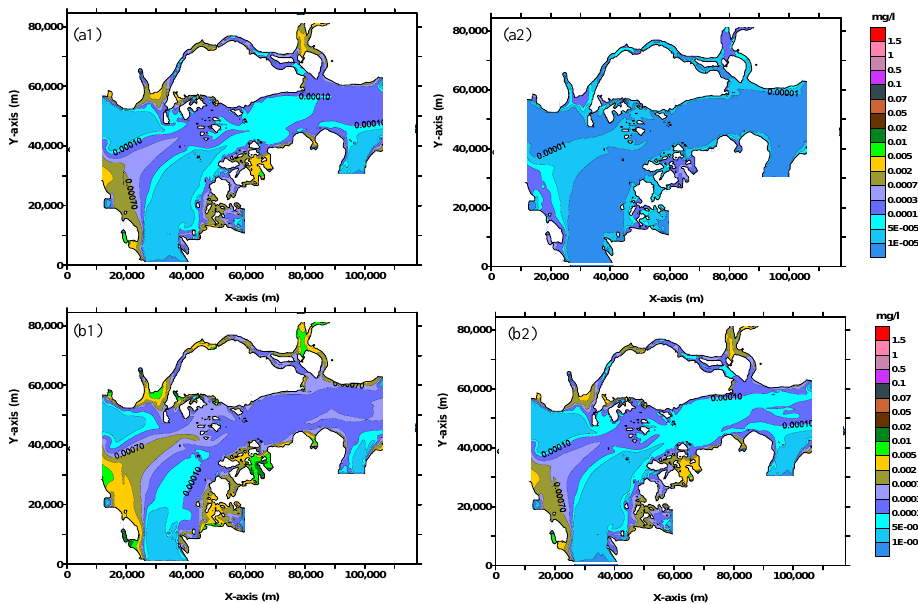
Fig. 8. The absolute change of (a) phosphate and (b) organic phosphorous concentration at surface water from baseline due to the atmospheric wet deposition during (1) hazy and (2) non-hazy days.